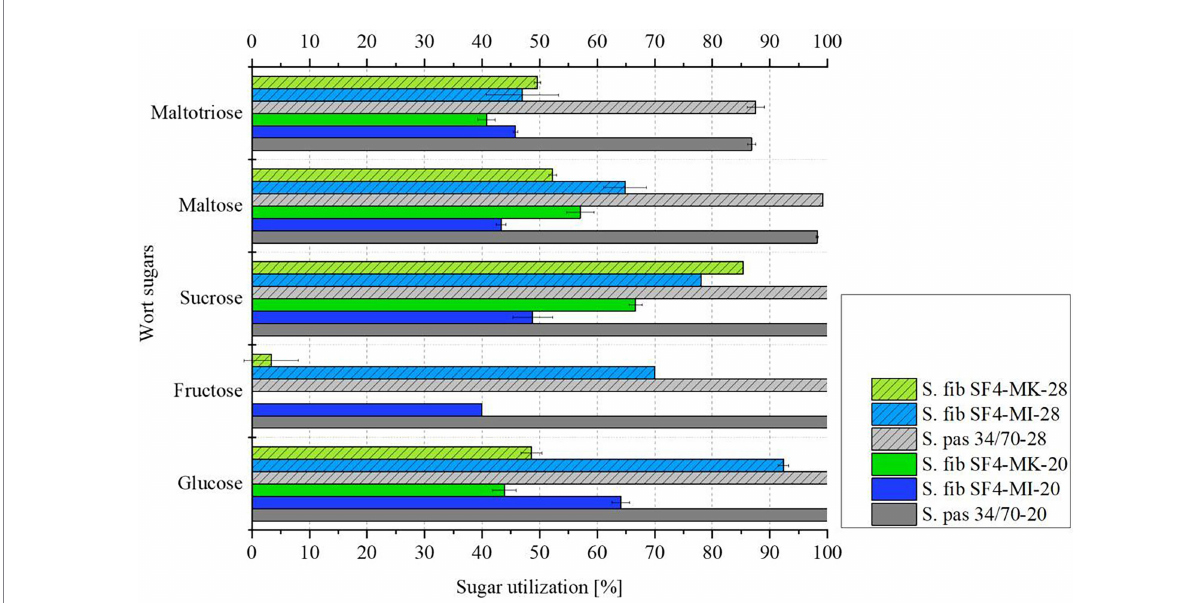
FIGURE 5 Mean values ( n = 3) with standard deviations of wort sugar utilization in % of the investigated yeast strain S. fib SF4 as micromanipulated (MI) and mother culture (MK) and the reference yeast strain S. pas 34/70 during fermentation from wort to beers at 20 and 28 °